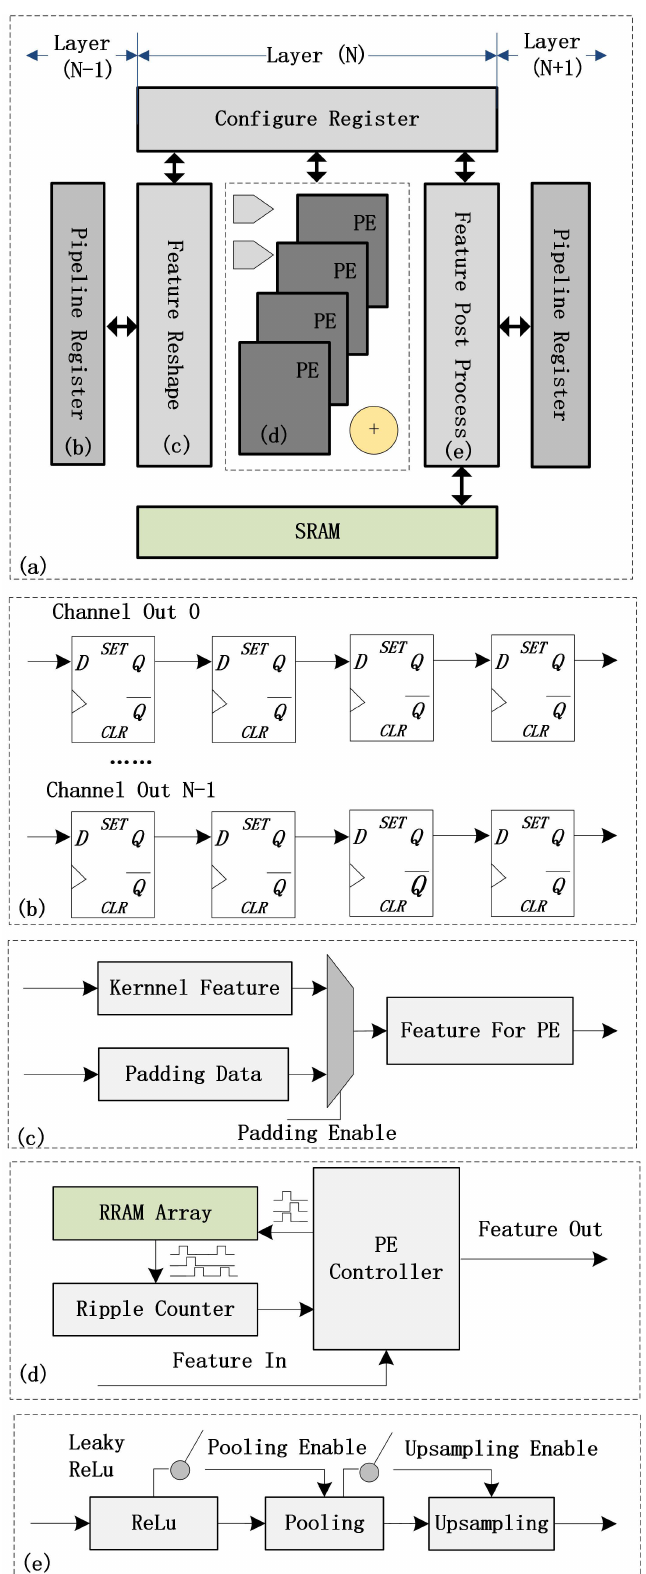
Figure 3. ( a ) Schematic illustration of the proposed RRAM PIM architecture; ( b ) The architecture consists of the pipeline register; ( c ) feature-reshaping module; ( d ) PE array; and ( e ) Post-feature processing